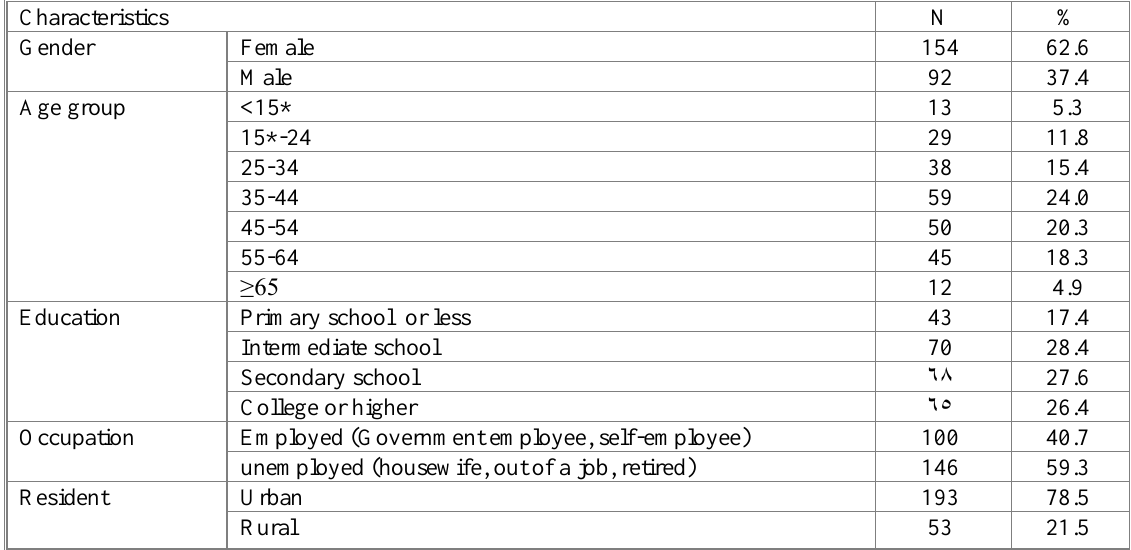
Table 1. Sociodemographic characteristics of participants Characteristics